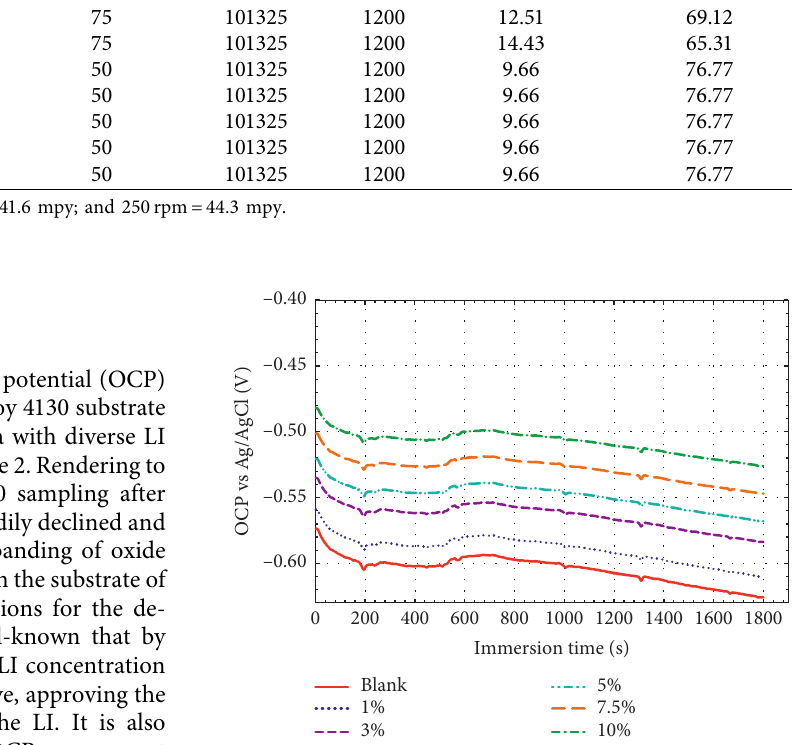
Figure 2: Open circuit potential vs. time of steel alloy 4130 sample engrossed in 3.5 wt.% M NaCl media and diverse loads of LI.